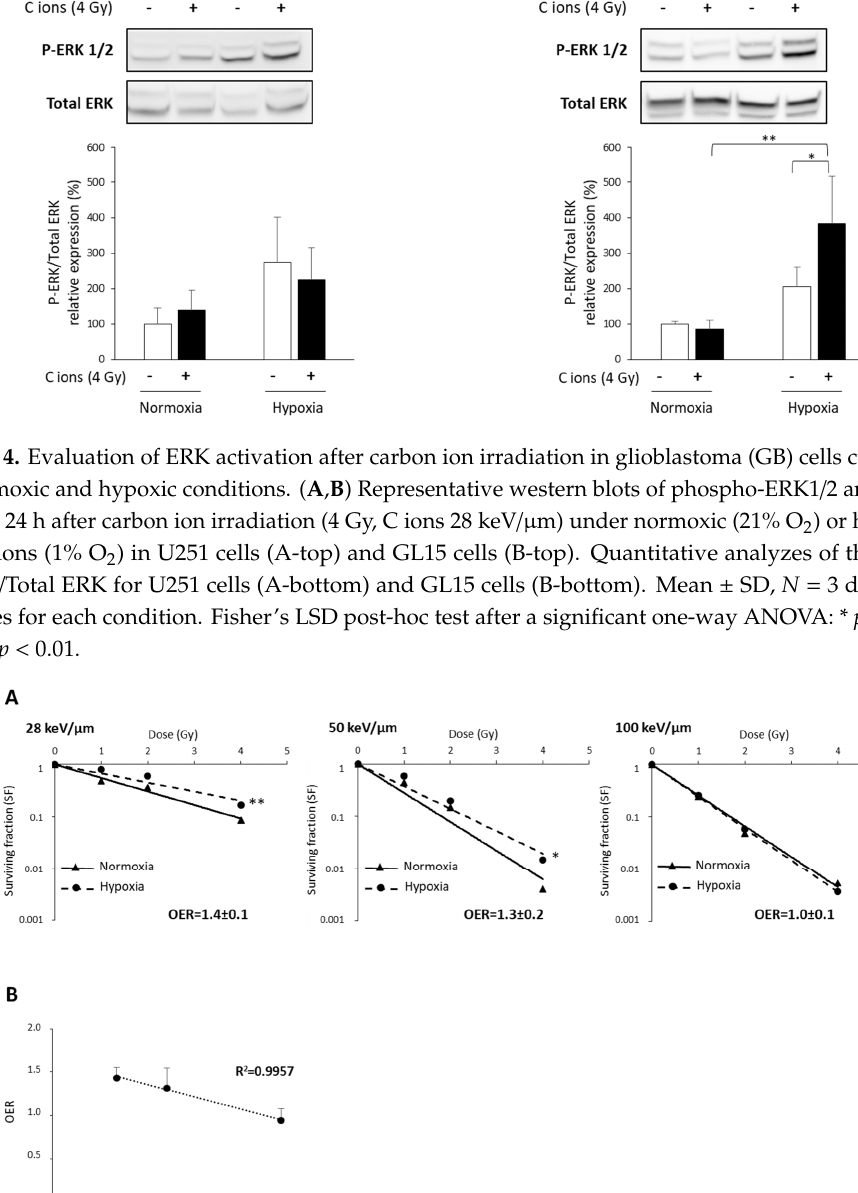
Figure 5. The relationship between oxygen enhancement ratio (OER) and LET of carbon ions in GL15 glioblastoma cells. ( A ) Survival curves of GL15 cells in normoxia (21% O 2 ) or hypoxia (1% O 2 ) exposed to carbon ion irradiation doses ranging from 0 to 4 Gy at different LET values (28 keV/µm, 50 KeV/µm, and 100 keV/µm). For each LET, OER quantification was performed from D37 determined in normoxia and hypoxia. ( B ) Negative correlation between OER and LET values. Mean ± SD, N = 3 different experiments performed in triplicate (n = 3) for normoxia and hypoxia conditions. Fisher’s LSD post-hoc test after a significant two-way ANOVA (oxygen and dose effects): * p < 0.05, ** p < 0.01 vs. normoxia.